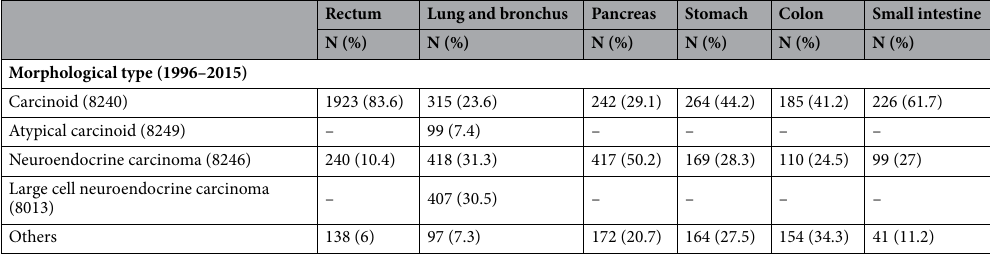
Table 2. The number and percentage of NETs in the 6 most common sites by morphological